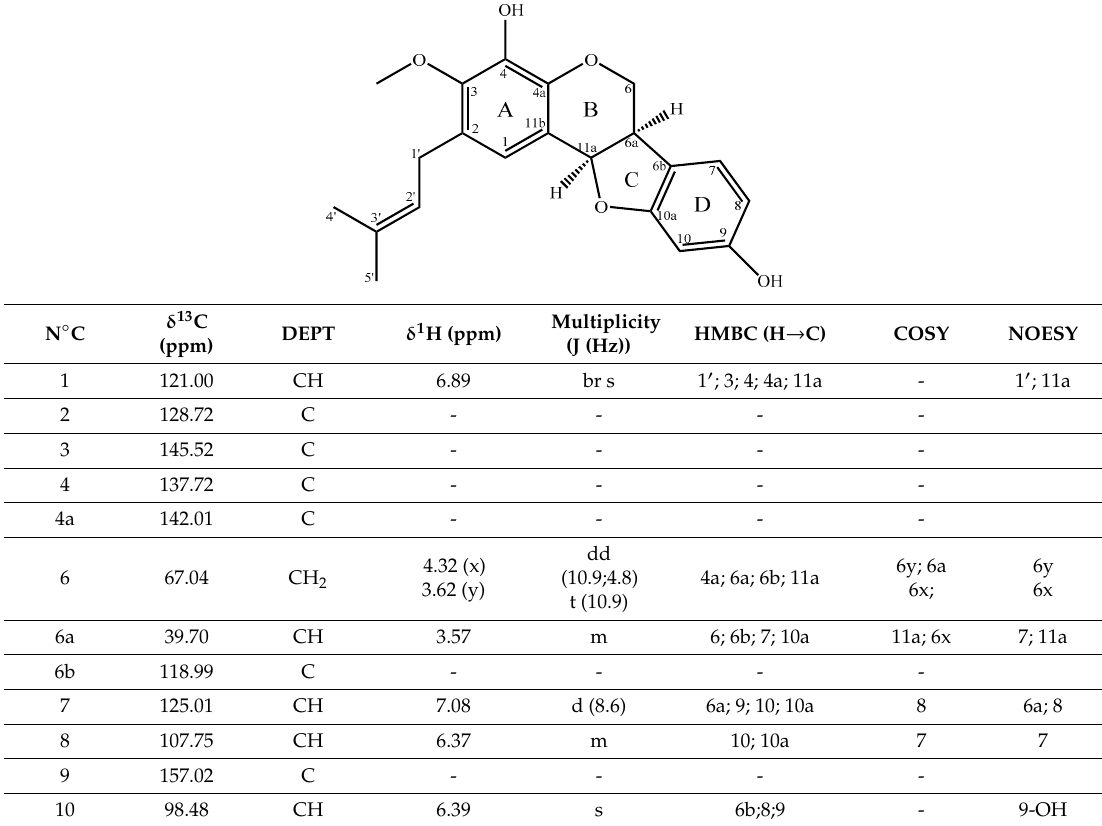
Table 2. Structure (relative stereochemistry) and NMR data of compound 2 .